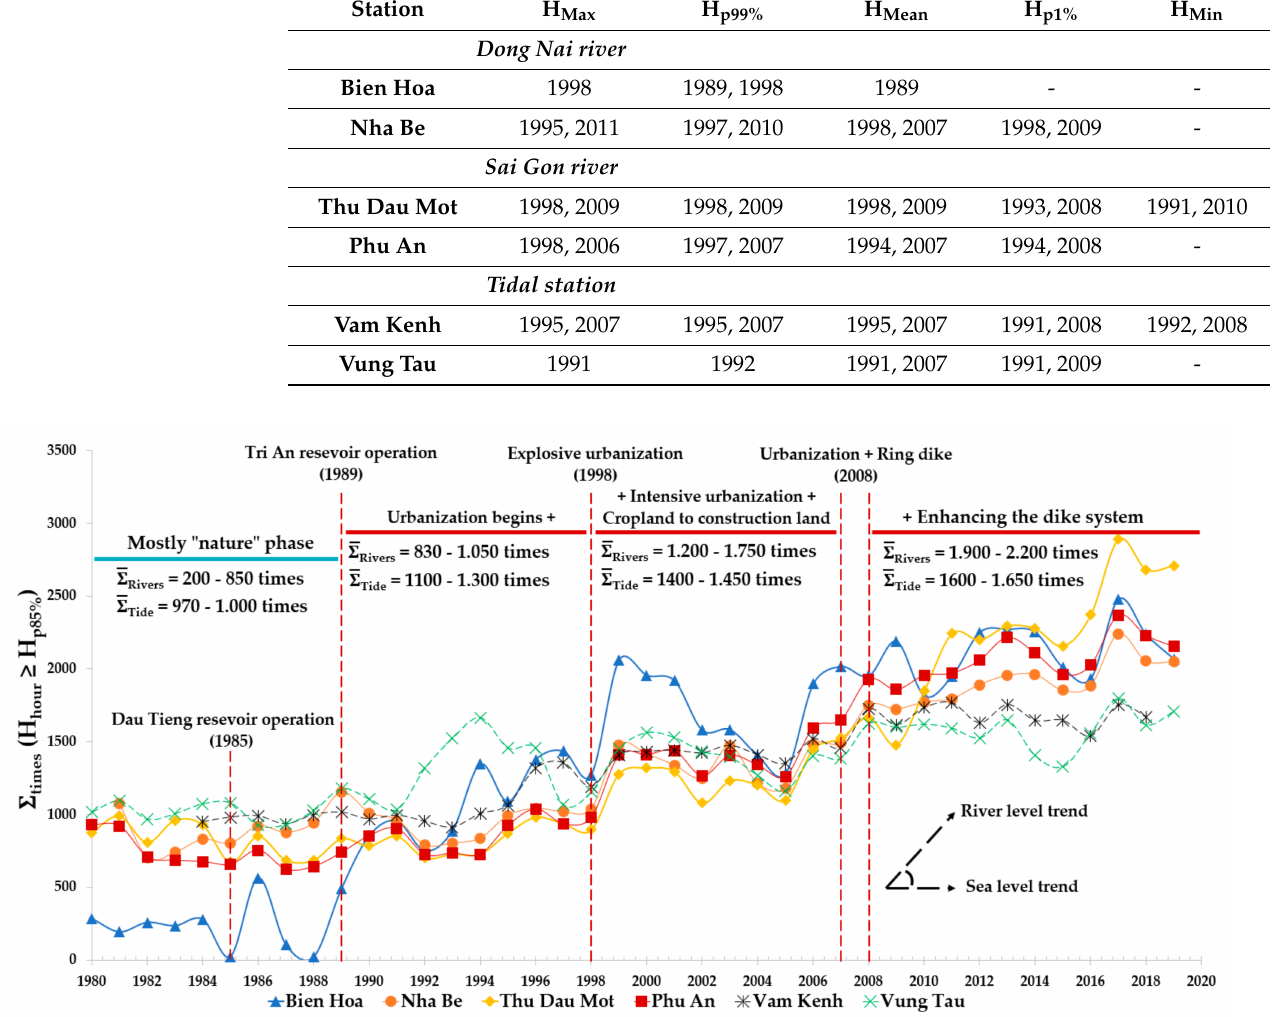
Table 5. Changepoint years selected for further analysis.